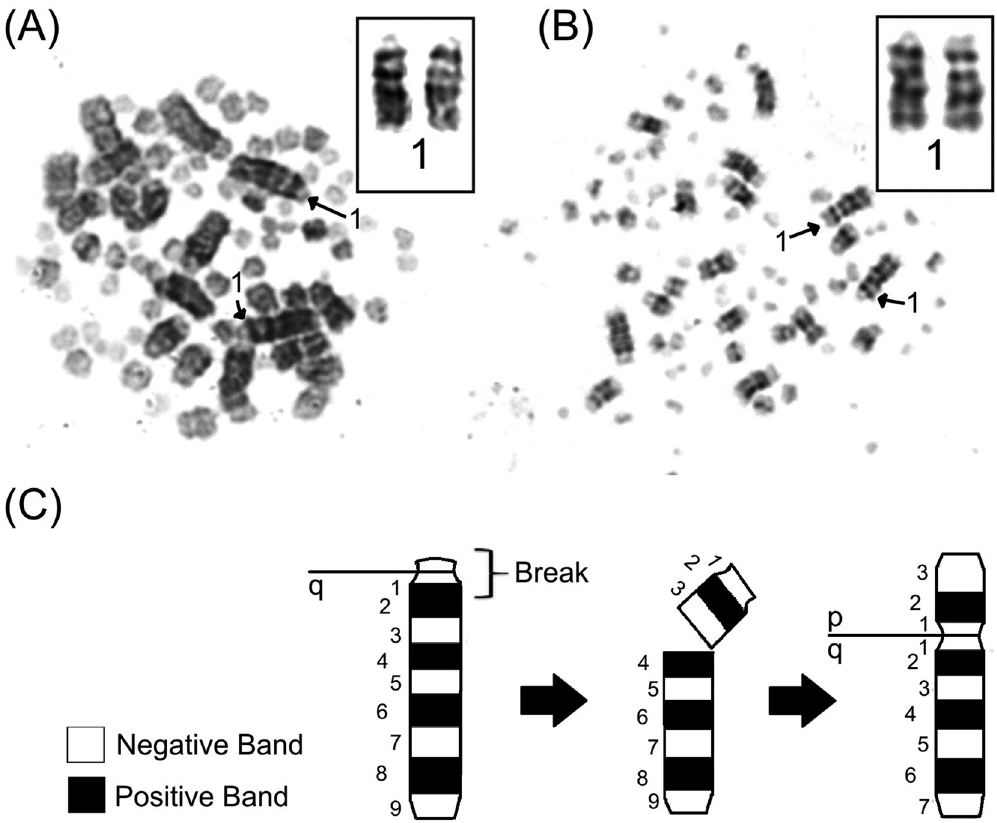
Figure2 -G-bandingpatternsfoundinstandardandpolymorphicindividuals.Metaphasisofastandard(A)andpolymorphic(B)bird;arrowsindicatethe first chromosome pair expanded in the box. (C) Schematic illustration of pericentric